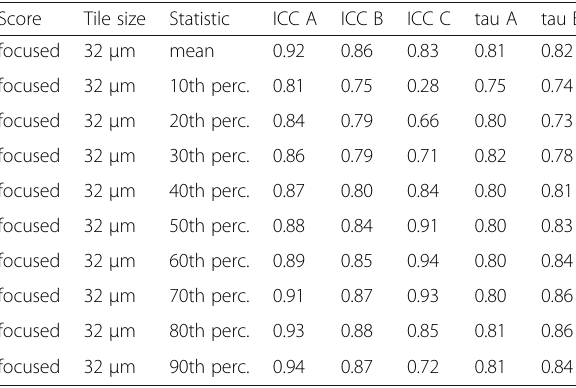
Table 2 Results of the percentile evaluation on data set A, B, and C. Kendall ’ s tau values were only computed for data set A and B because validity assumptions could only be made for these data